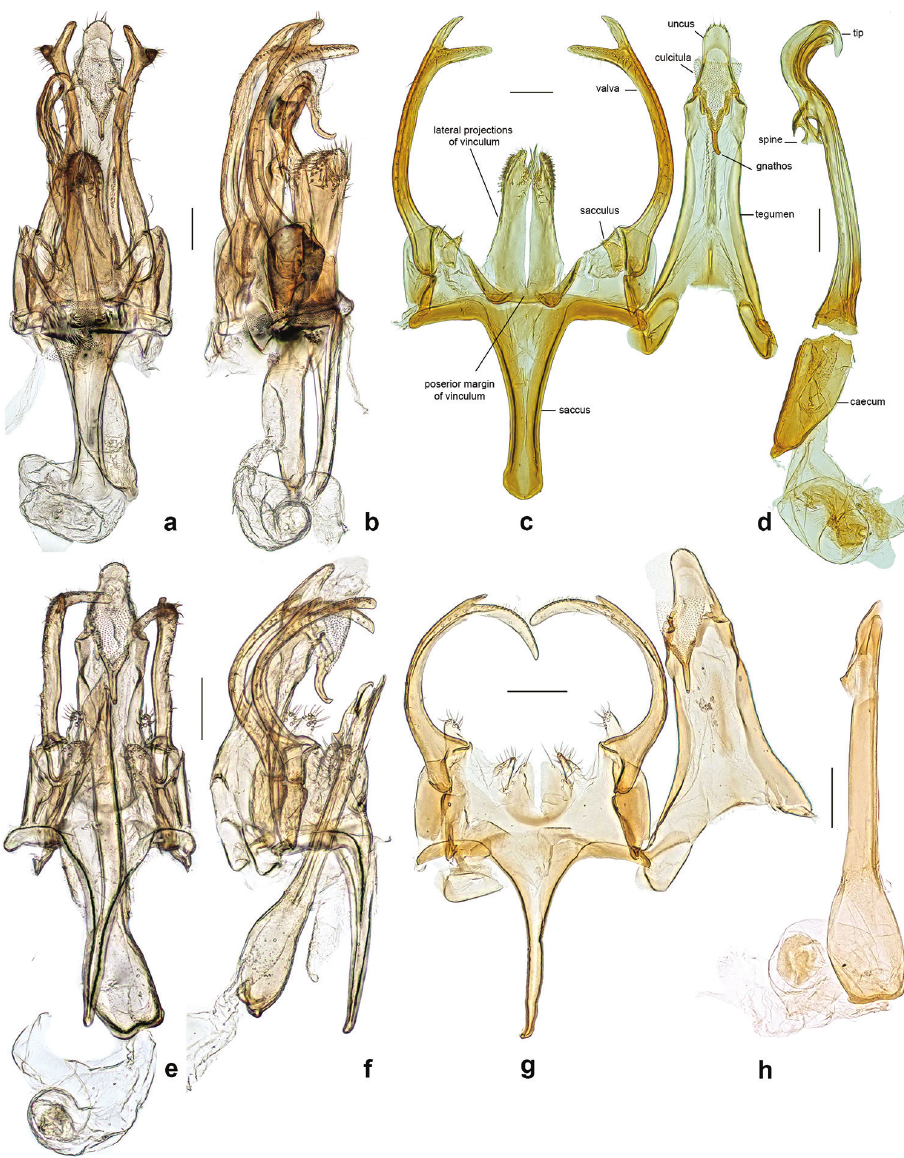
Figure 3. Male genitalia of Neopalpa species. a–d N. neonata e–h N. donaldtrumpi sp. n. a, b ventral and lateral view of intact genitalia, unmounted, stored in lactic acid (LACMENT326710, CA: River- side County) c, d Unrolled genitalia and phallus of the Holotype (EMEC82306, dissection Pw1168) e, f ventral and lateral view of intact genitalia, unmounted, stored in lactic acid (UCRC ENT 461717, CA: Riverside County) g, h Unrolled genitalia and phallus of the Holotype (UCBME021628; dissection VNZ241). Scale bar 100